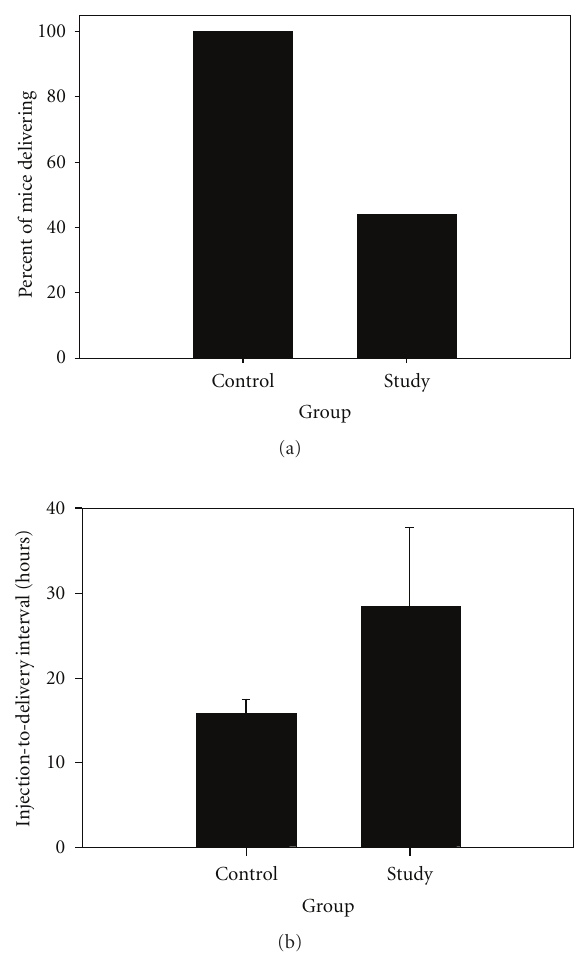
Figure 1: E ff ect of the MMP inhibitor GM6001 on preterm delivery in the mouse model. (a) Incidence of preterm delivery in the mouse model in either the absence (control group) or presence (study group) of GM6001 after i.p. 3.3 mg/kg LPS injection ( P < . 01, Fisher’s exact test). (b) Change in LPS injection-to-delivery time interval in hours, in the control group versus study group ( P < . 005, Mann-Whitney